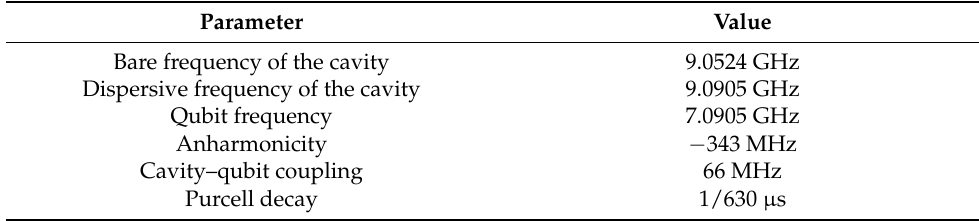
Table A1. Parameters of the